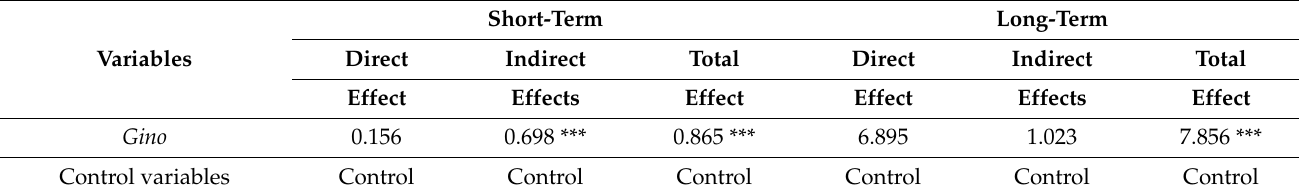
Table 6. Effect decomposition of the base regression.